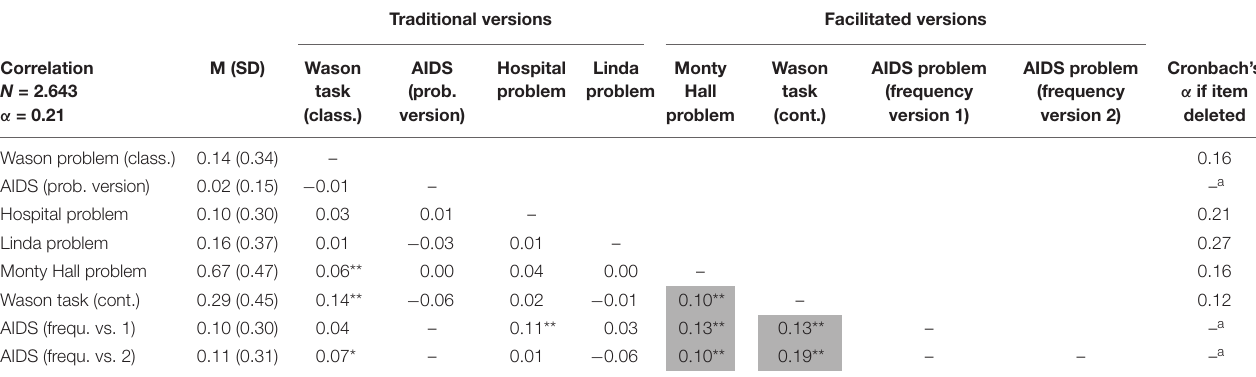
TABLE 1 | # correct solutions (in percent), standard deviations, and manifest intercorrelations of cogIll items including Cronbach’s alpha if item